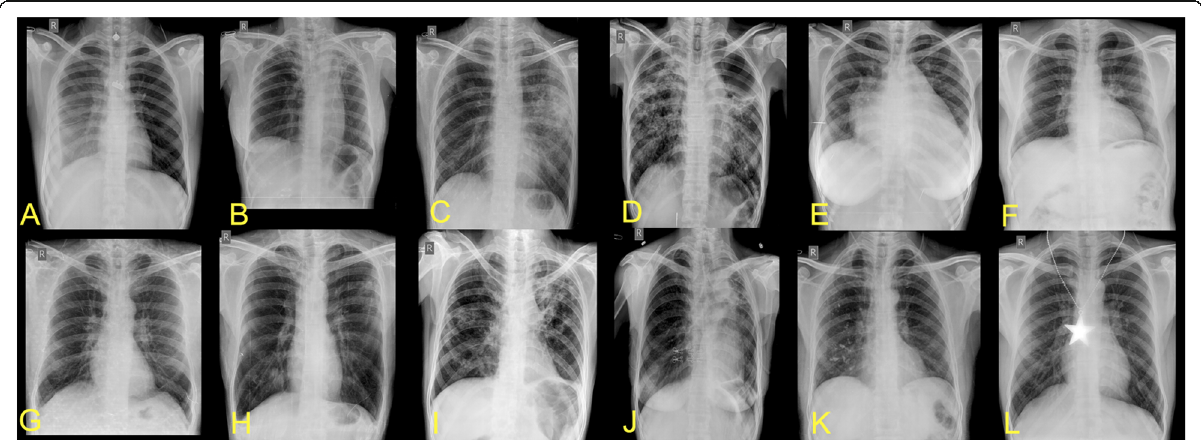
Fig. 4 Examples from the training data set. Right-sided pleural effusion ( a ). Fibrosis in left upper zone ( b ). Consolidation in bilateral lung fields ( c ). Multiple pathologies in single radiograph — showing patchy consolidation with fibrotic bands and bulla in left upper zone ( d ). Cardiomegaly ( e ). Left hilar prominence ( f ). Prominent bronchovascular markings ( g ). Emphysema ( h ). Blunted left costophrenic angle with patchy consolidation ( i ). Collapse of left upper and middle zone ( j ). Nodular opacities in right lower zone ( k ). Normal chest radiograph with clothing artifact ( l )